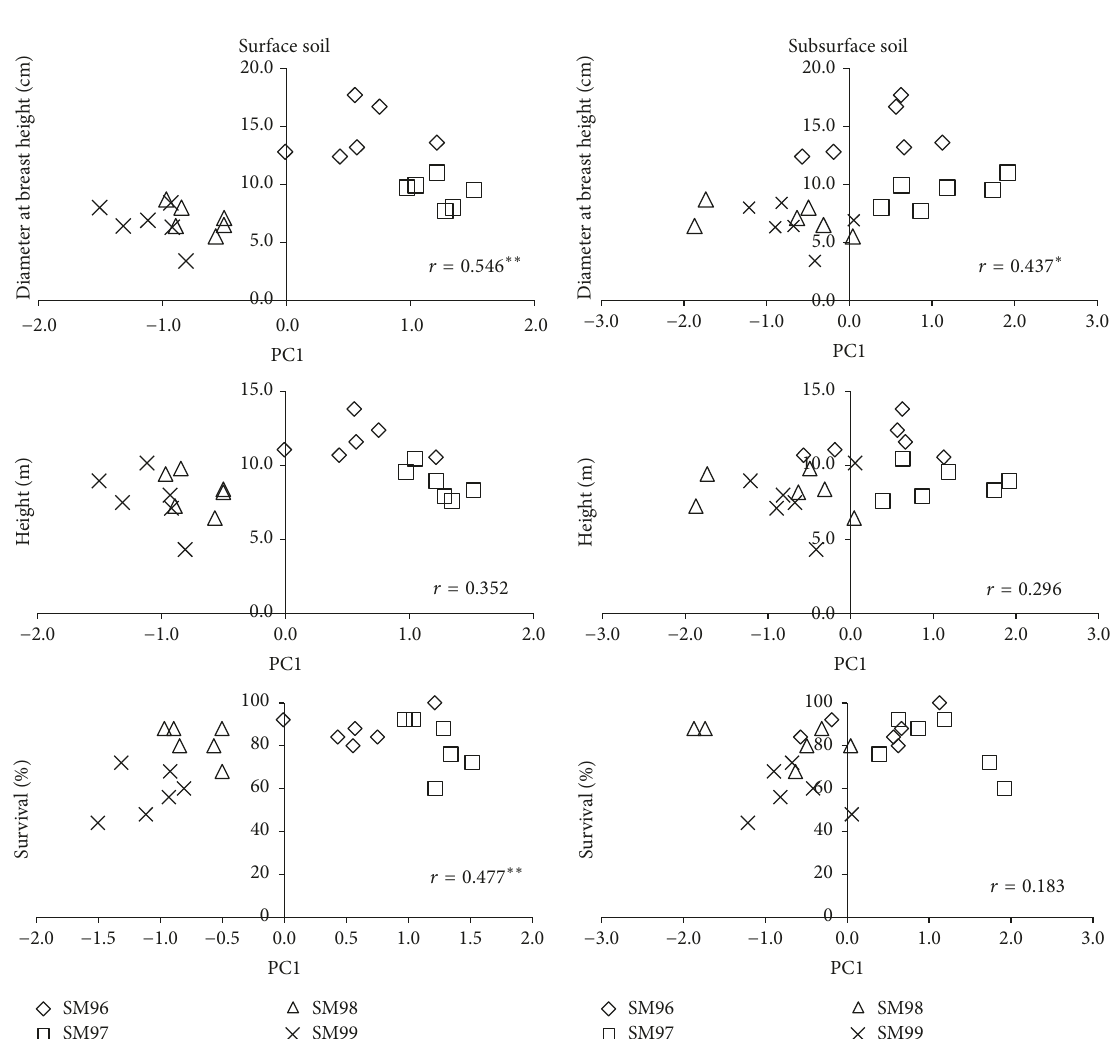
and SFI at surface soils ( 𝑟 = 0.789 ∗∗ , P < 0.01) but no soils ( 𝑟 = 0.546 ∗∗ , P < 0.01 and 𝑟 = 0.477 ∗ , P < 0.05,